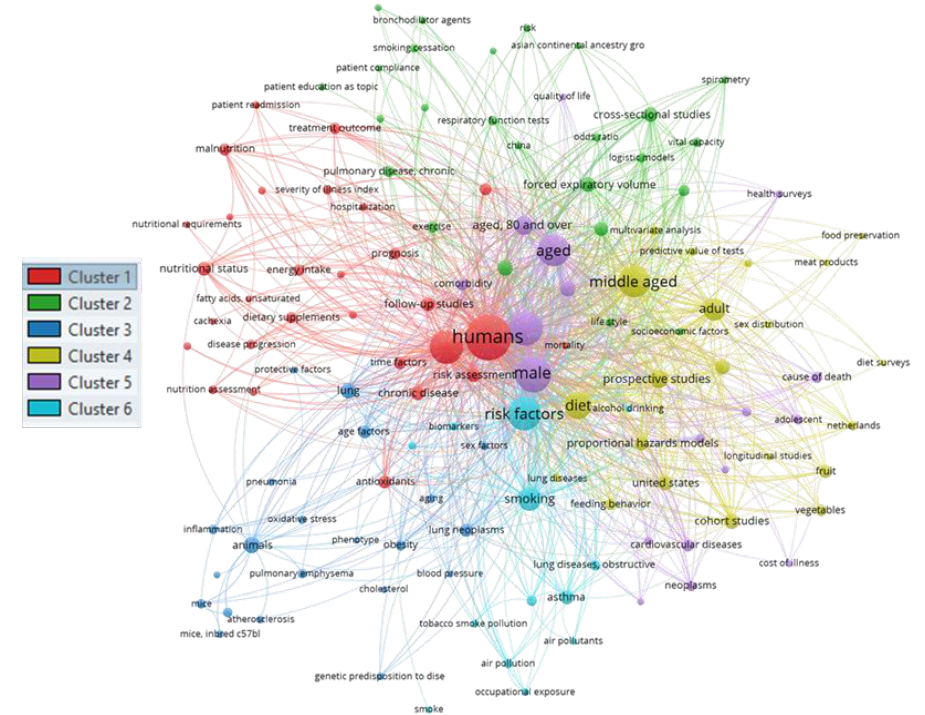
Figure 1. The bubble map visualizes 127 keywords extracted from published papers retrieved in PubMed under the search terms “diet” and “chronic obstructive pulmonary disease risk” between 1989 and 2019. Bubble size indicates the frequency of occurrence of the words, while bubble color represents the cluster of belonging. Words are clustered based on direct citation relations; thus, each cluster corresponds to a set of closely related words. Two bubbles are in closer proximity if the two words had more frequent